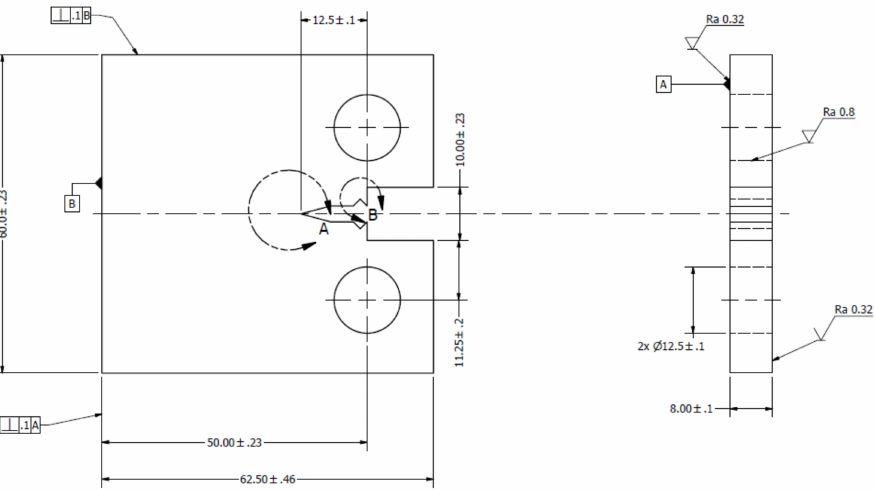
Figure 2. Design of compact tension specimen for fatigue crack growth rate experiment (all dimen- sions in